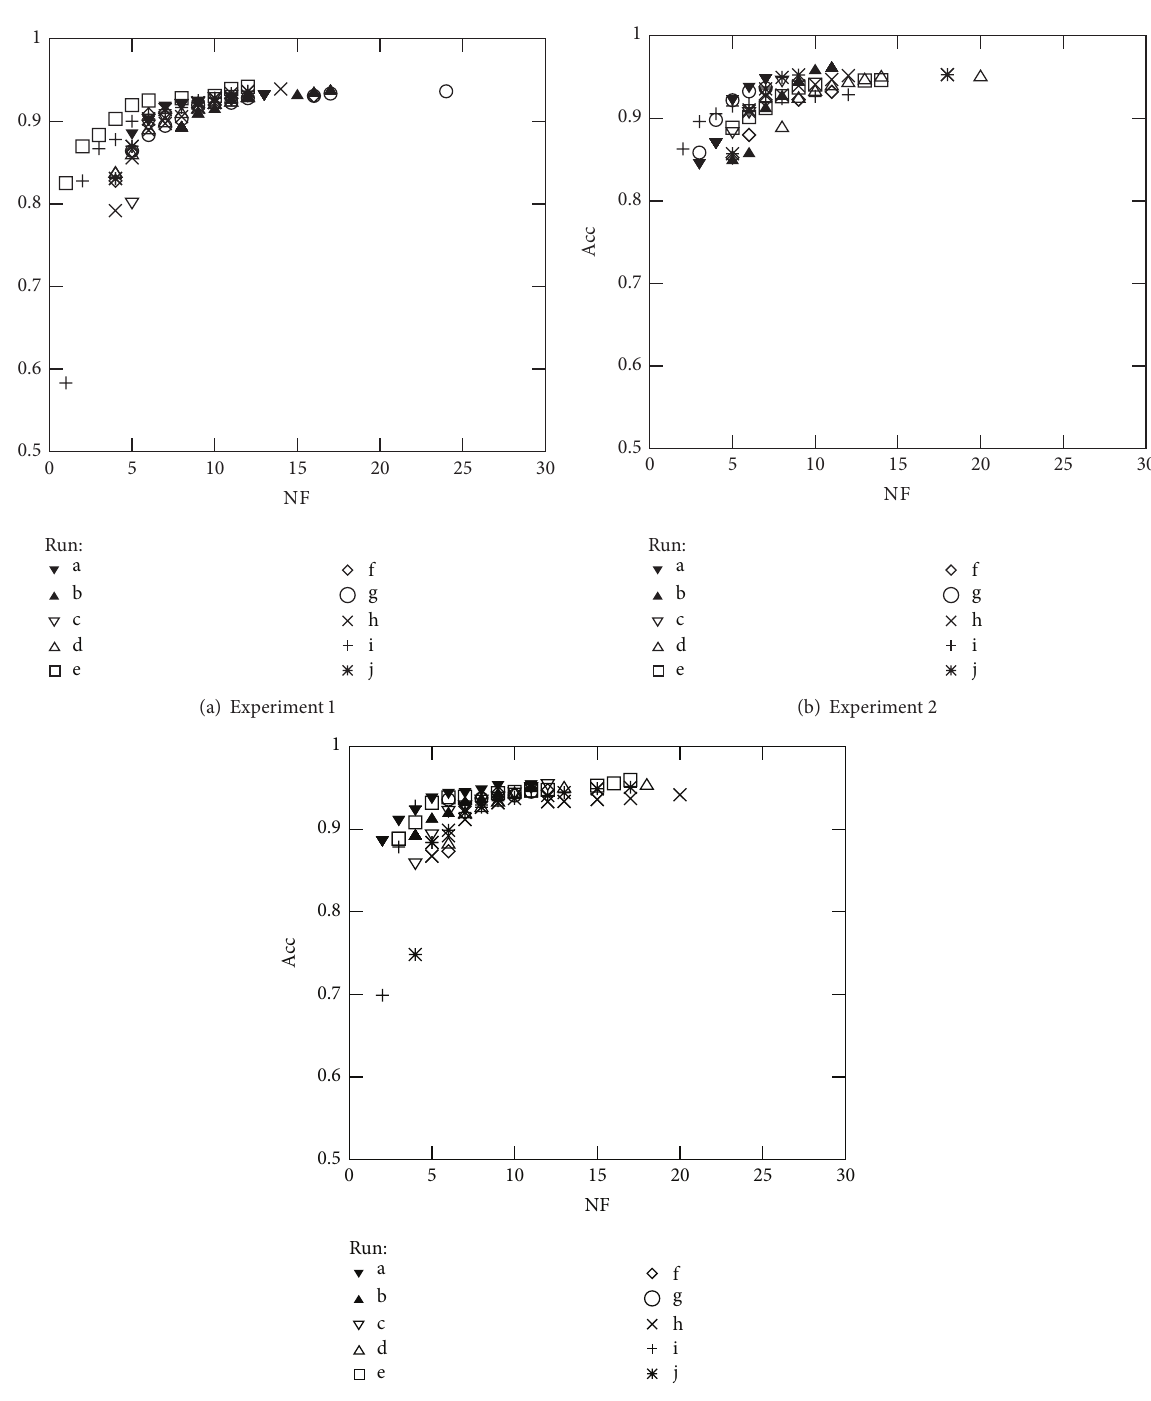
Figure 8: Optimal Pareto fronts for Diane 2006 data (10